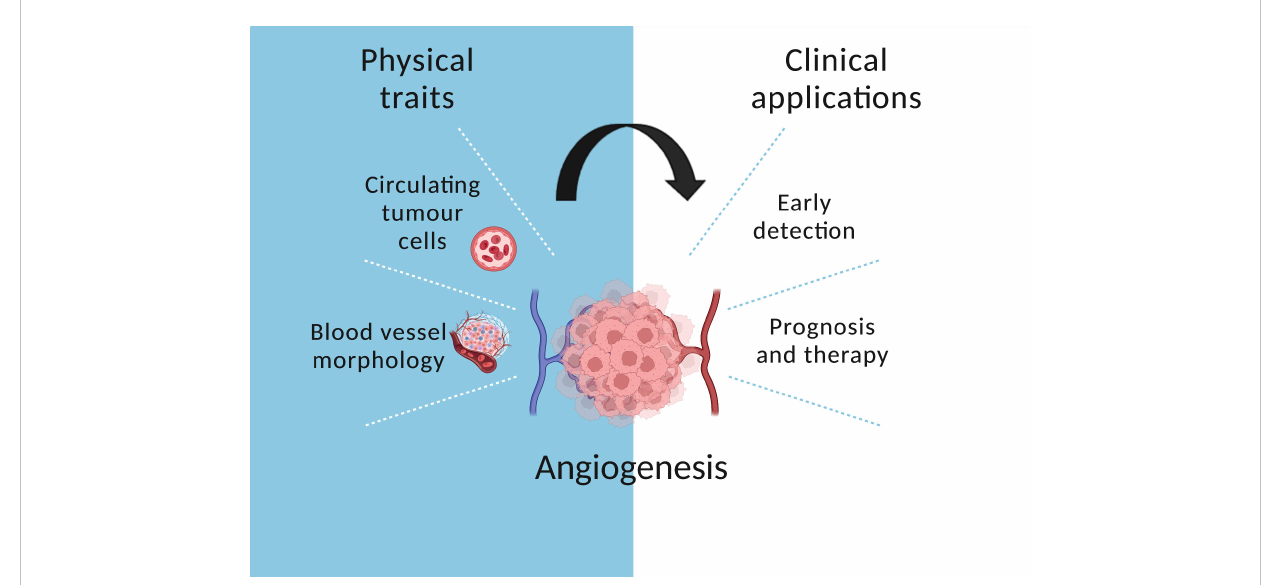
FIGURE 3 The role of angiogenesis in cancer evolution. Circulating tumour cells are released in the bloodstream which enables early detection. In addition, blood vessel morphology informs prognosis and